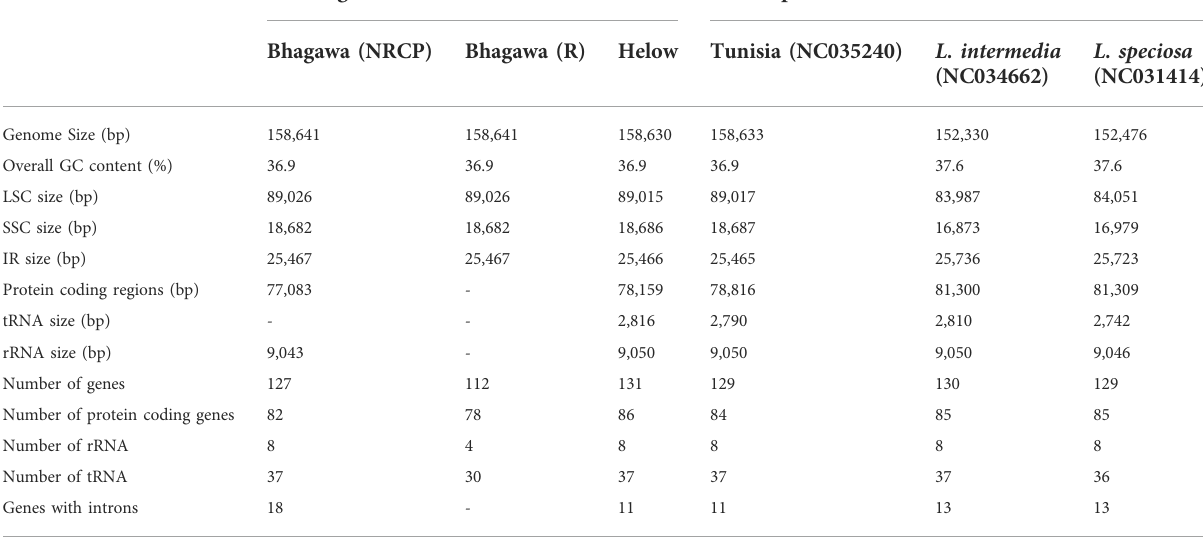
TABLE 4 Comparison of the “ Bhagawa (NRCP) ” chloroplast genome with other